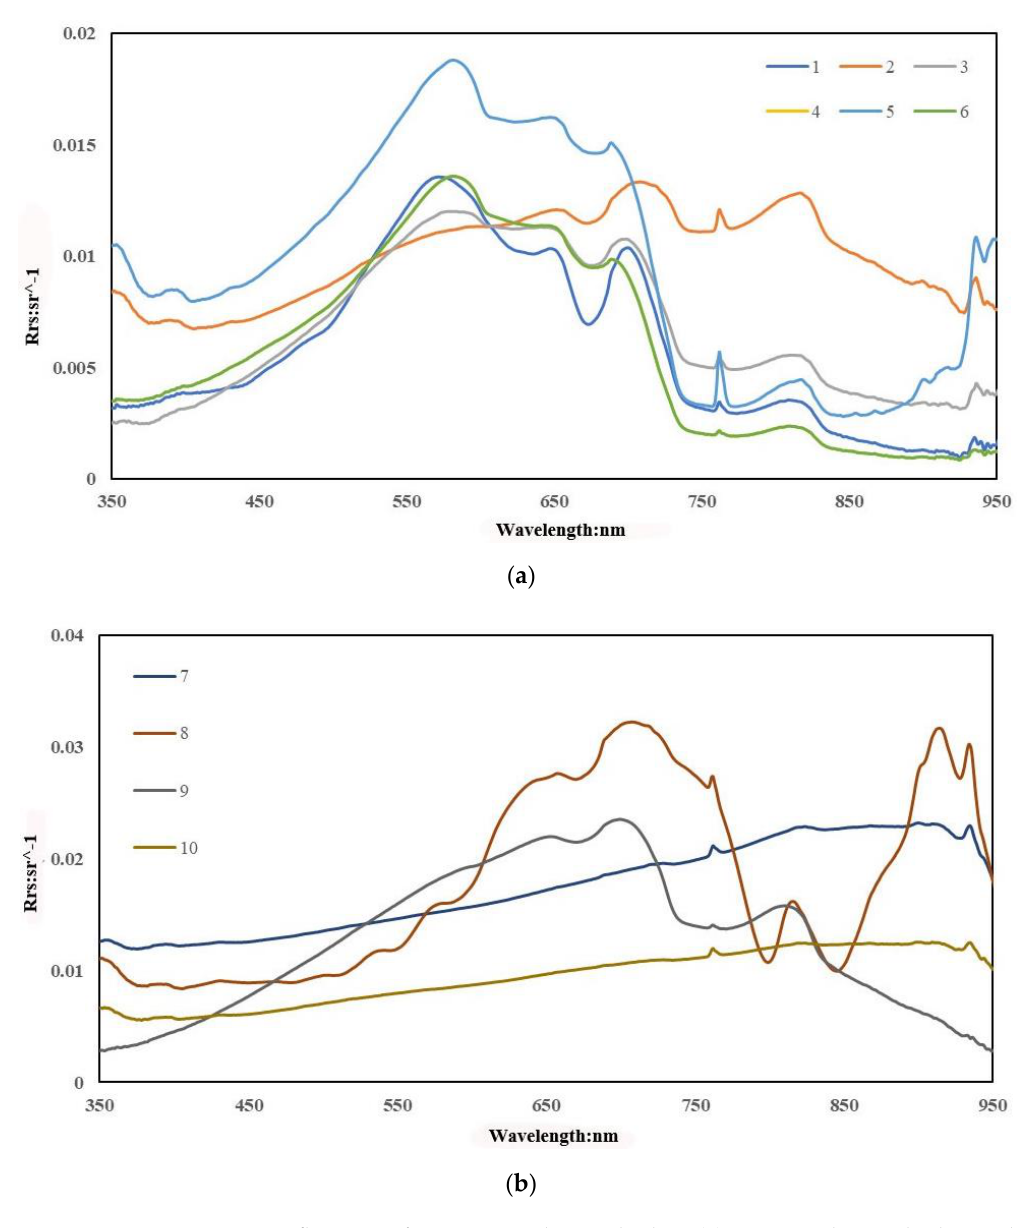
Figure 7. Remote-sensing reflectance of ten measured water bodies: ( a ) six general water bodies and ( b ) four water colour anomalies.